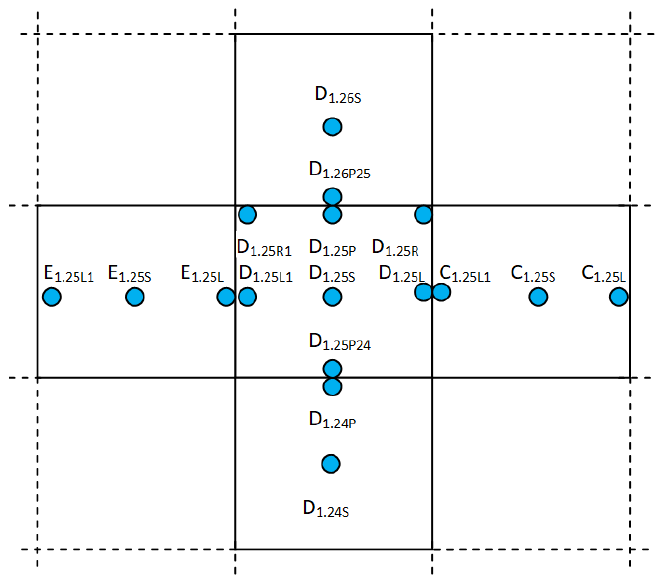
Figure 1. Locations of falling weight deflectometer (FWD) load plate on runway (RWY).